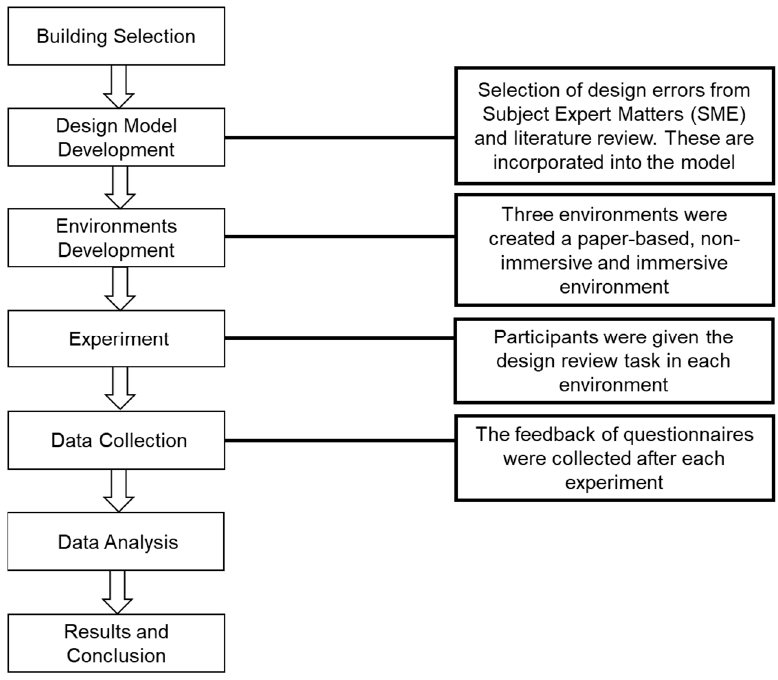
Figure 3. Experimental procedure steps .